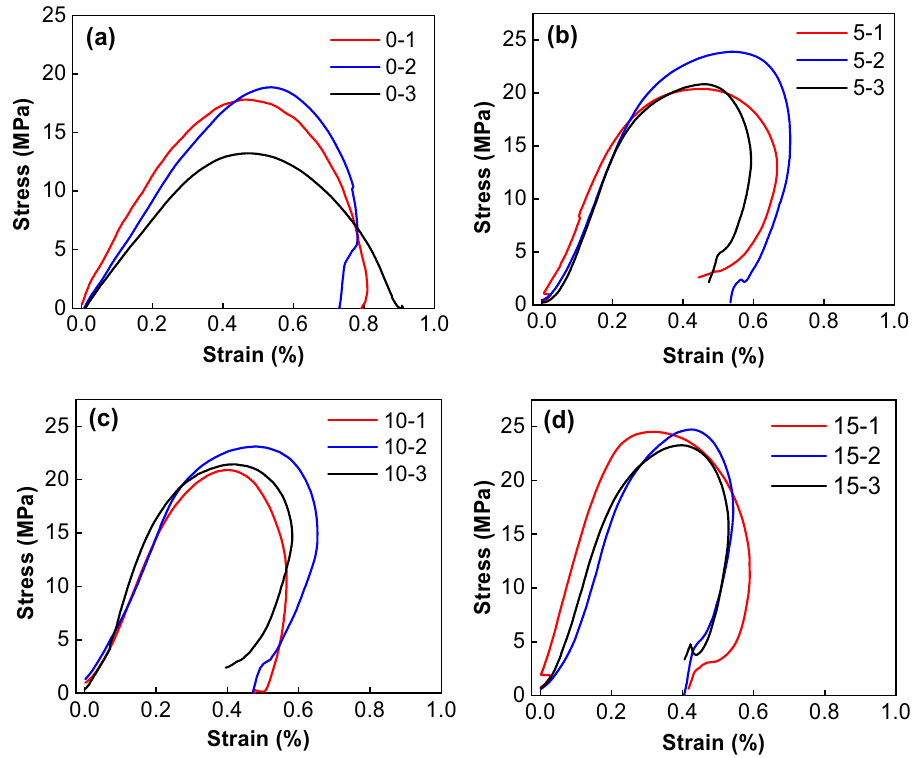
Figure 14. Dynamic stress–strain curves of combined bodies under different confining pressures. ( a ) 0 MPa, ( b ) 5 MPa, ( c ) 10 MPa, ( d ) 15 MPa.